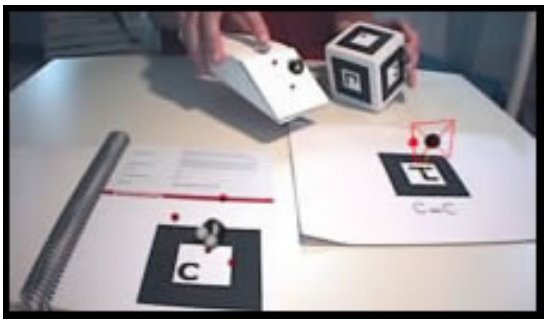
Fig. 2. Augmented Chemistry in use. The user holds a claw with the right hand and a cube for orientation with the left hand. On the bottom left corner there is a catalogue of periodic elements and over the marker on the right there is the molecule assembled by the